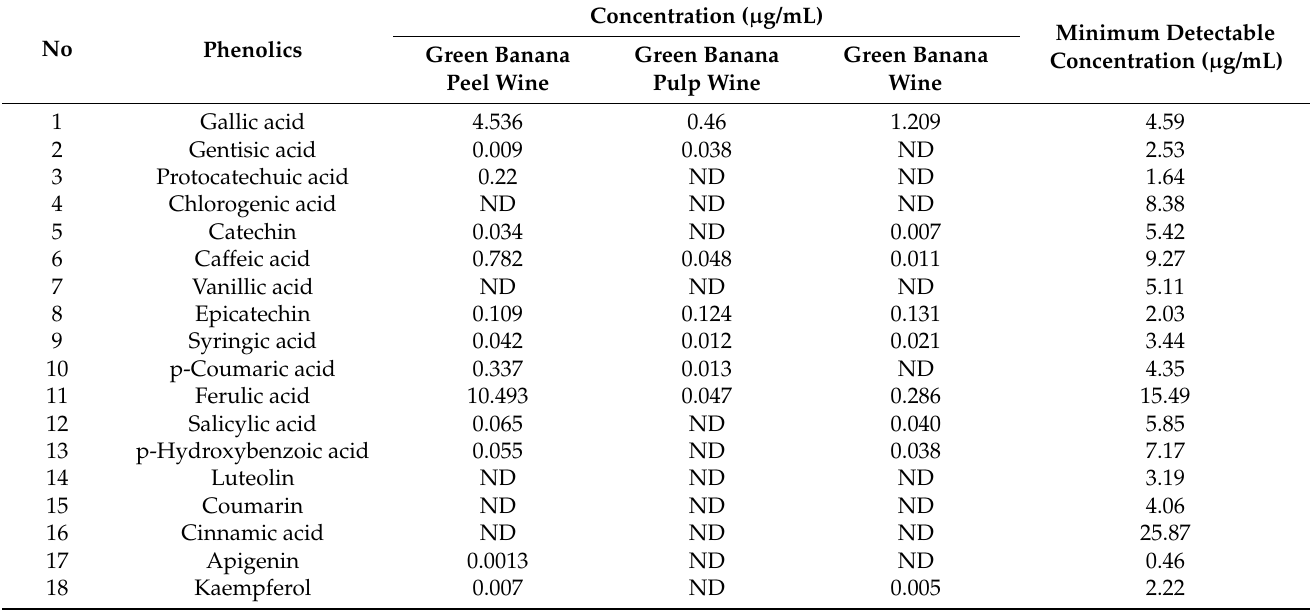
Table 2. Phenolics content in green banana wine